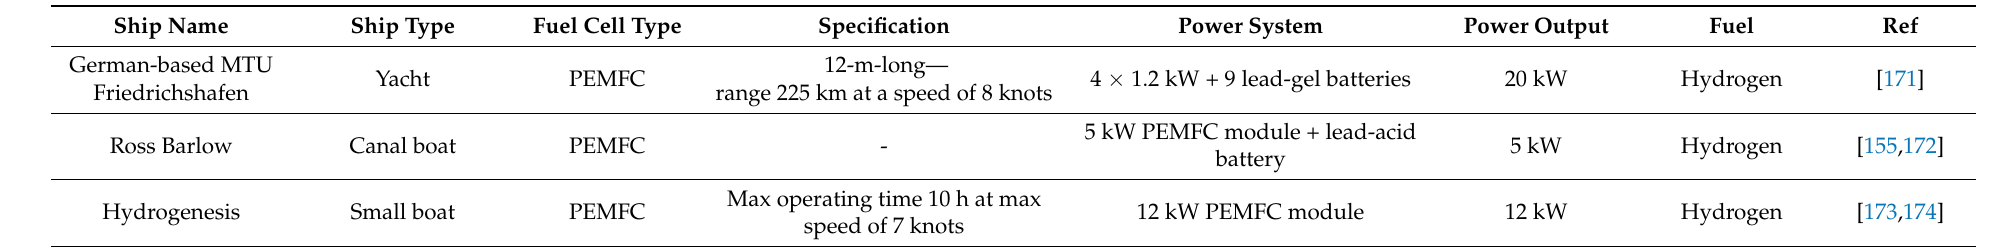
Table 6. Overview of maritime applications powered by fuel cell